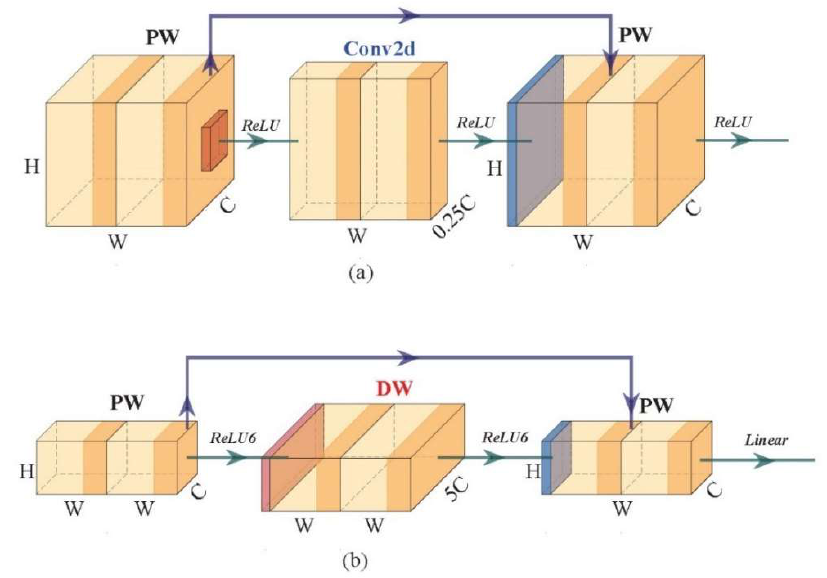
Figure 5. Residual block and inverted residual block, ( a ) Residual block, ( b ) Inverted residual block with linear Bottleneck.